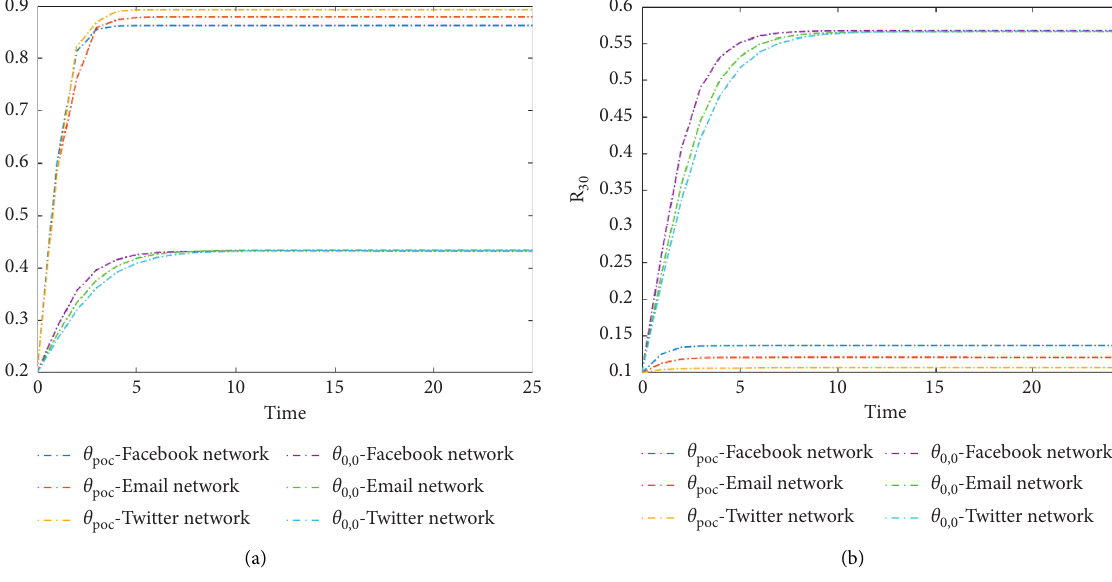
and (b) expected probability of refusing for 0 , 0